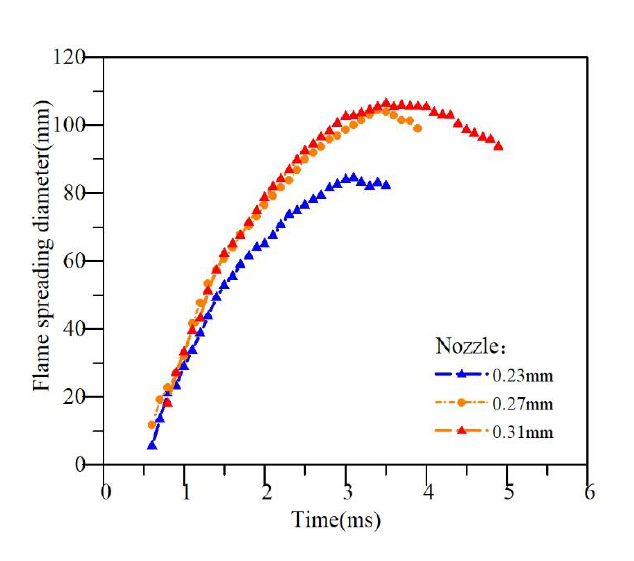
Figure 13. Spreading diameter of impinging flame.